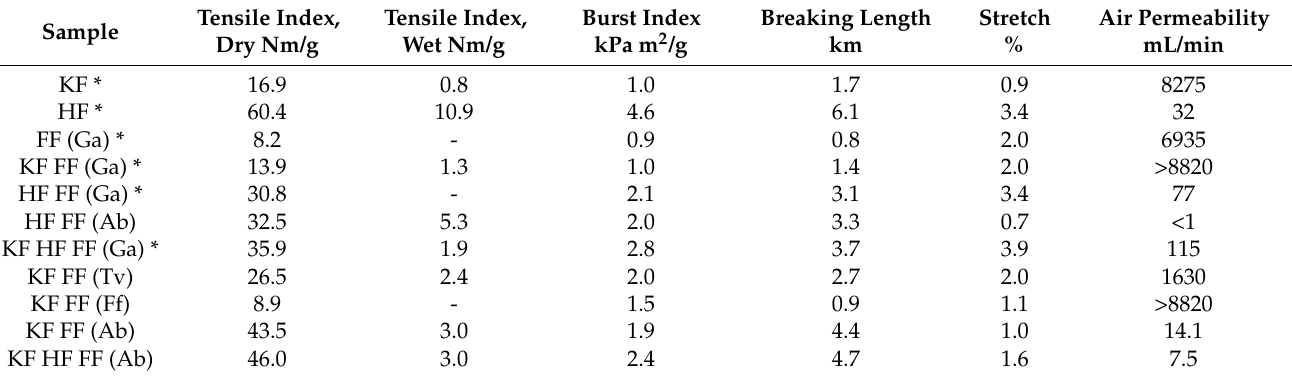
Table 1. Mechanical and air permeability properties of mycocel biopolymer materials (KF = Kraft fibers; HF = hemp fibers; FF = fungal fibers; Ga = G. applanatum ; Ab = A. bisporus ; Tv = T. versicolor ; Ff = F. fomentarius ). The marked (*) samples have been described previously